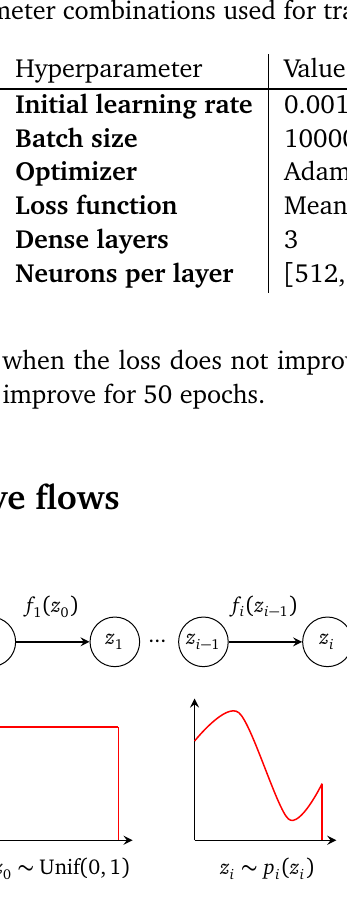
Figure 2: Visualisation of the autoregressive flow. The flow model starts from a uniform distribution and transforms it into a target distribution which is inferred from the training data. After training, the model can be used to evaluate the likelihoods of